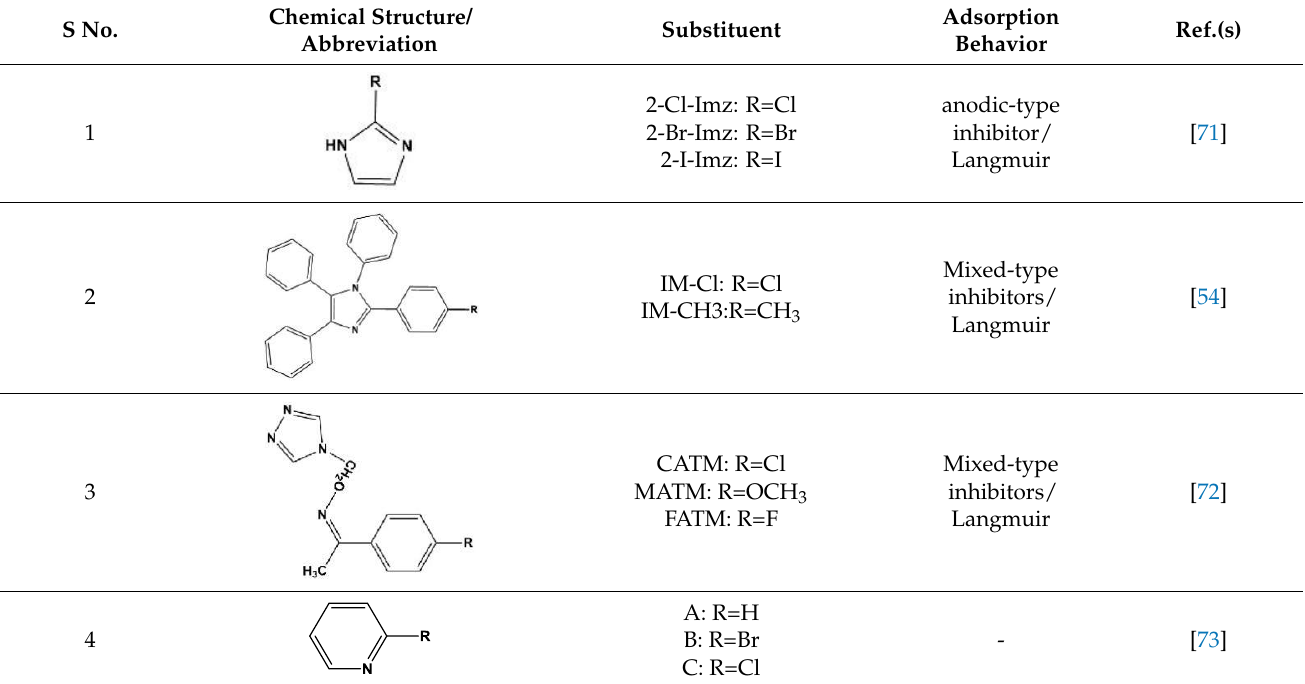
Table 4. Molecular structure and adsorption behavior of halogen-substituted N-heterocycles.